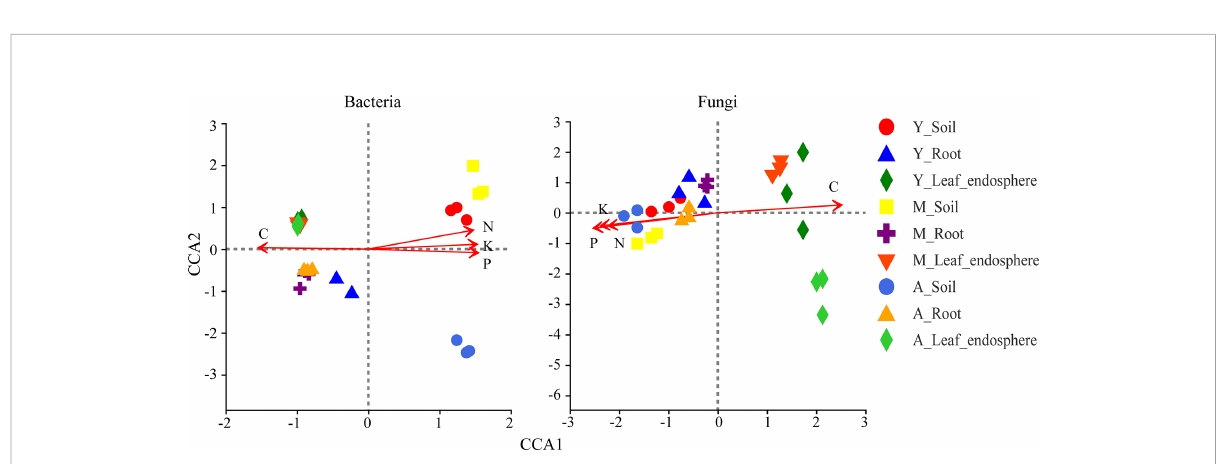
FIGURE 8 Canonical correlation analysis of bacteria (left) and fungi (right) genera in different niches in the genus stand. Red arrow represents environmental factors, and the length of the arrow represents the degree of impact of environmental factors on species data. Angle between the arrows of environmental factors represents positive and negative correlations (acute angle: positive correlation; obtuse angle: negative correlation; right angle: no correlation). Sample points were projected onto the arrows of quantitative environmental factors, and the distance between the projection points and the origin represents the relative in fl uence of environmental factors on the distribution of sample communities. C, carbon; N, nitrogen; P, phosphorus; K,